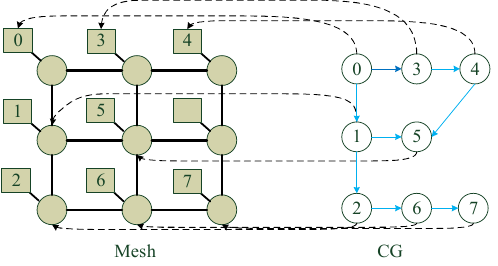
Figure 1. Application mapping diagram.